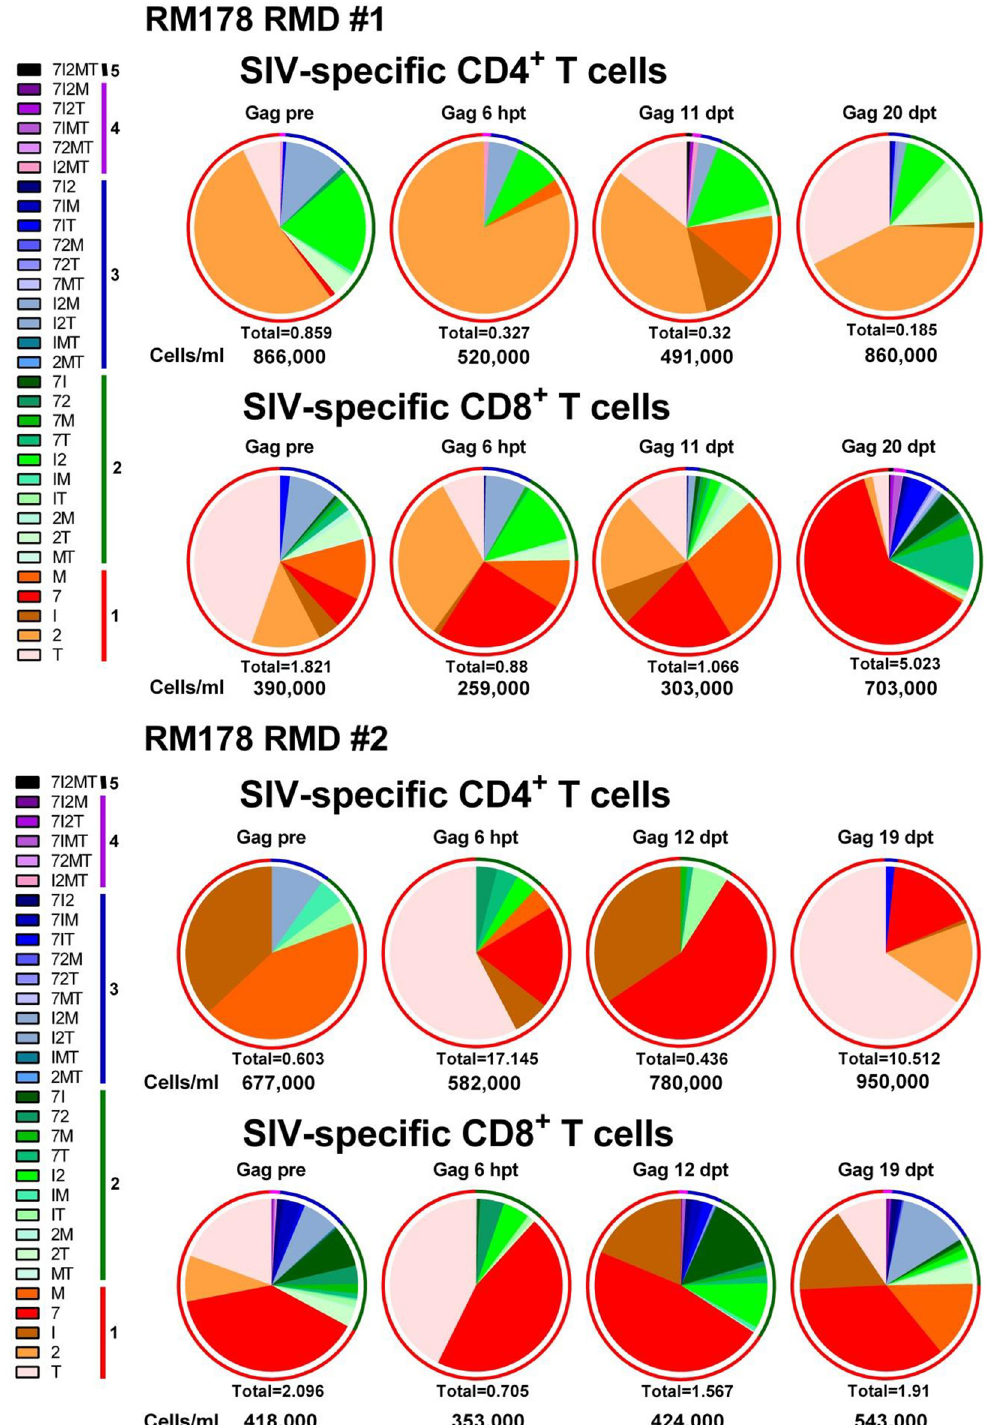
Fig 8. RMD administration does not significantly impact Gag SIV-specific T cell responses or functionality in SIVsmmFTq post-treatment controller RM178. Serial monitoring of SIV-specific T cell polyfunctionality after two rounds of RMD administration was achieved by stimulating PBMCs with Gag SIVmac239 peptide pools followed by intracellular cytokine staining. Cytokines tested include: TNF- α (T); IL-2 (2); IFN- γ (I); CD107 α (7); and MIP-1 β (M). Data are representative of all RMs. Absolute numbers of CD4 + /CD8 + T cells/ml for each timepoint